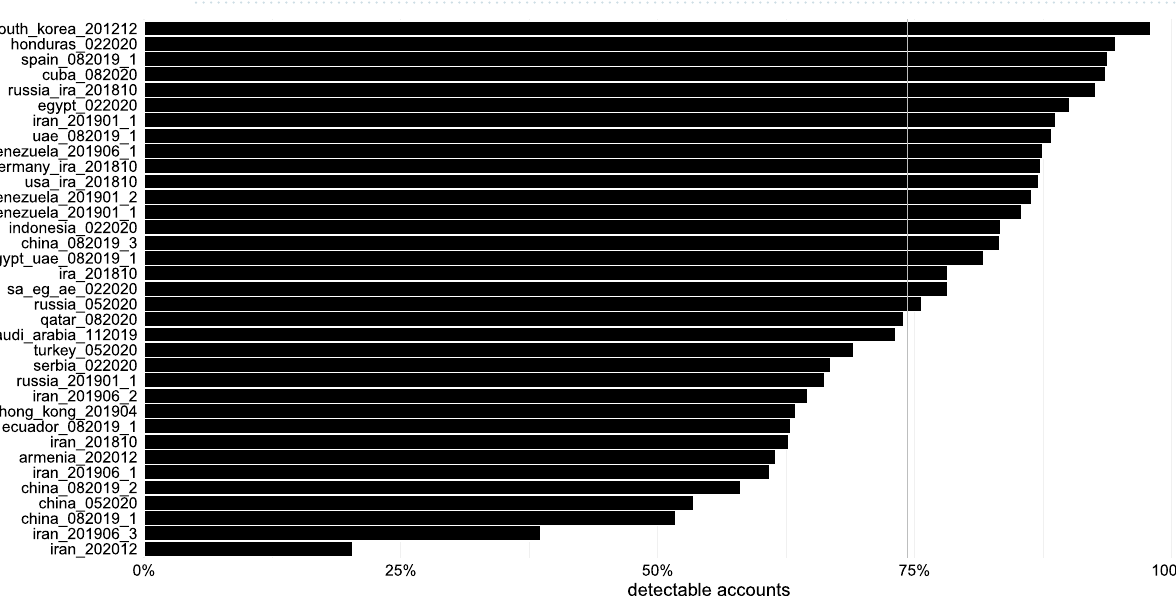
Figure 6. The methodology detects on average 74% of all accounts involved in a campaign. Detected astroturfing accounts based on appearance in either the co-tweet or co-retweet network (one-minute threshold) for all campaigns released by Twitter with more than 50,000 tweets. Campaign labels reflect information provided by Twitter in their data releases. Grey line indicates the